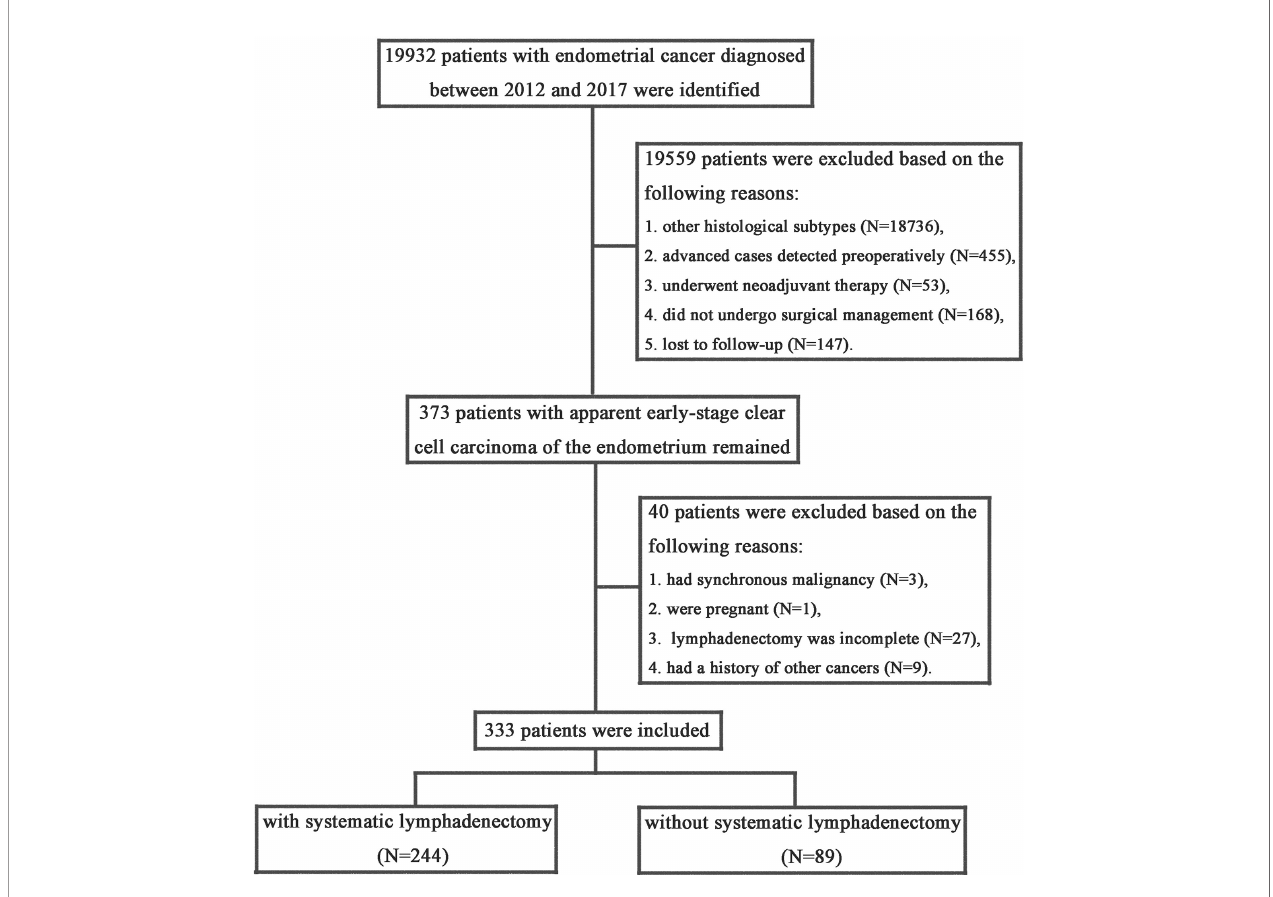
FIGURE 1 | Flow chart of patients